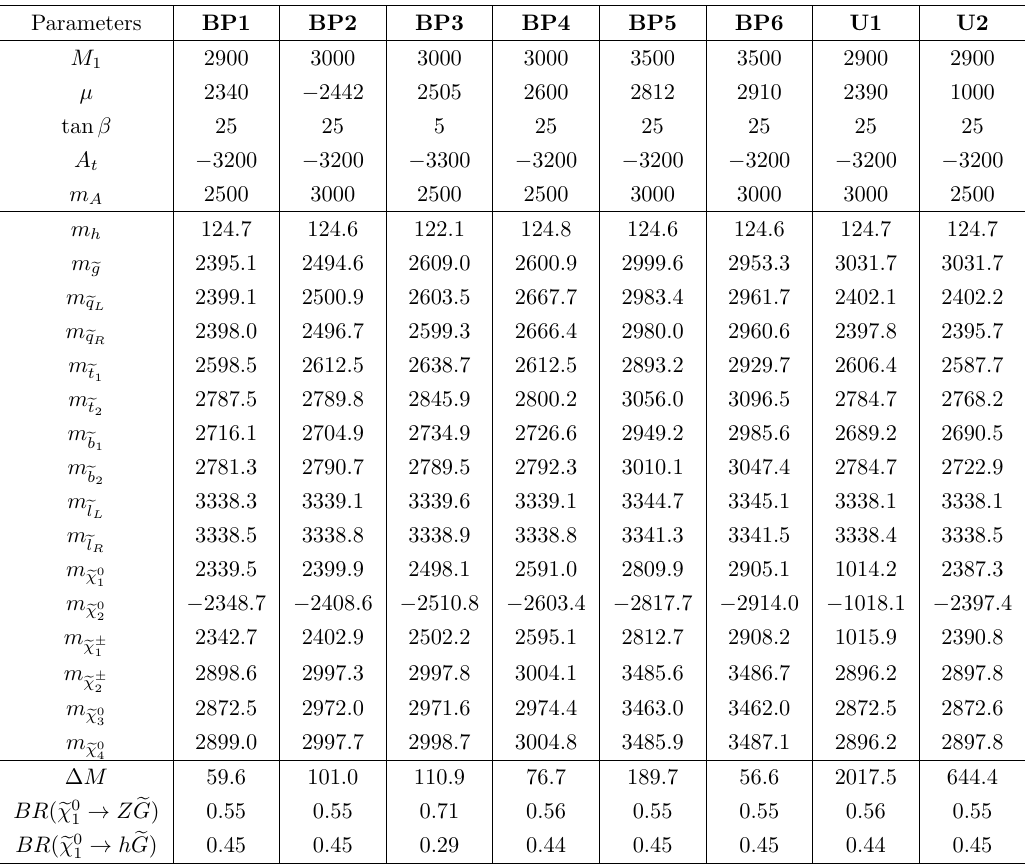
Table 3 . List of benchmark points, corresponding parameters and NLSP branching ratios chosen for our study. The mass parameters are in GeV unless speci(cid:12)ed otherwise. For all benchmarks, gravitino mass is kept (cid:12)xed at m = 1 e G